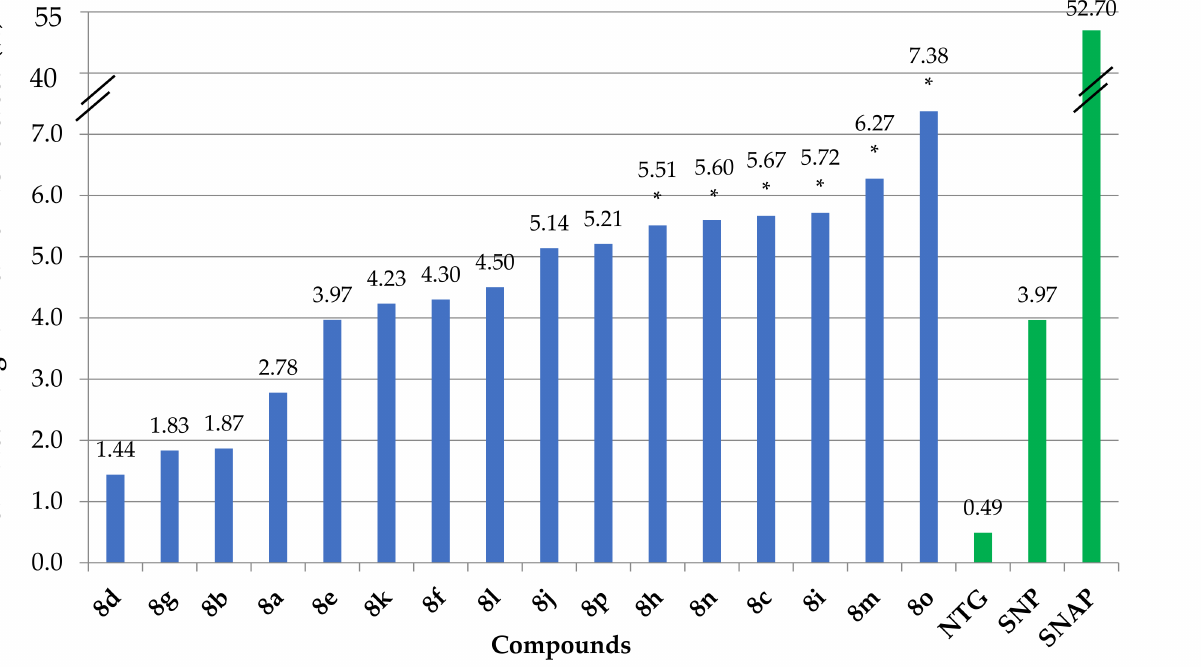
Figure 7. The estimated marginal means of NO (%) release by NO-IND-OXDs ( 8a–p ) compared to reference NO donors (NTG, SNP, SNAP) (* significantly more NO released than SNP, p <